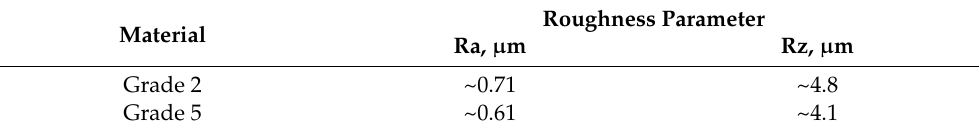
Table 3. Roughness of strip